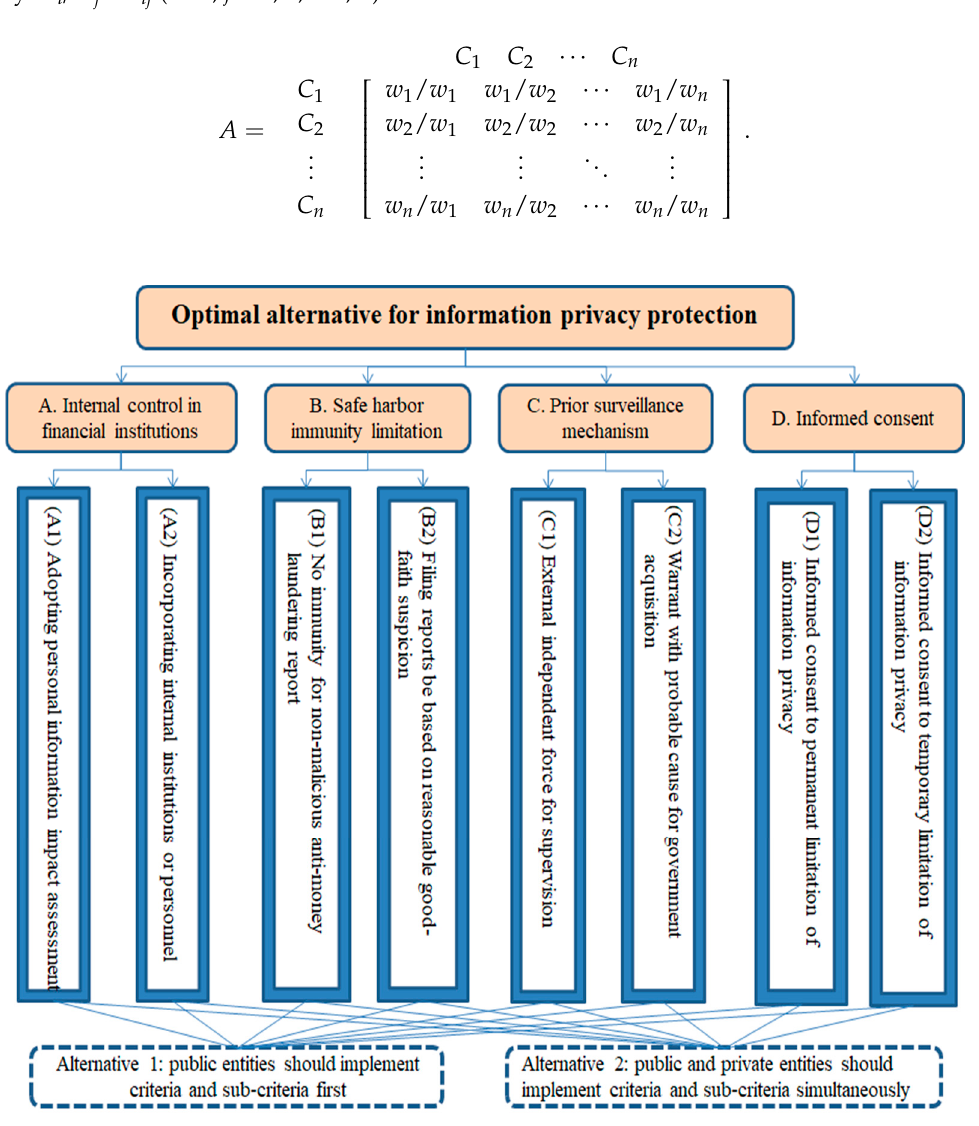
Figure 1. Hierarchical layer structure of the information privacy protection.